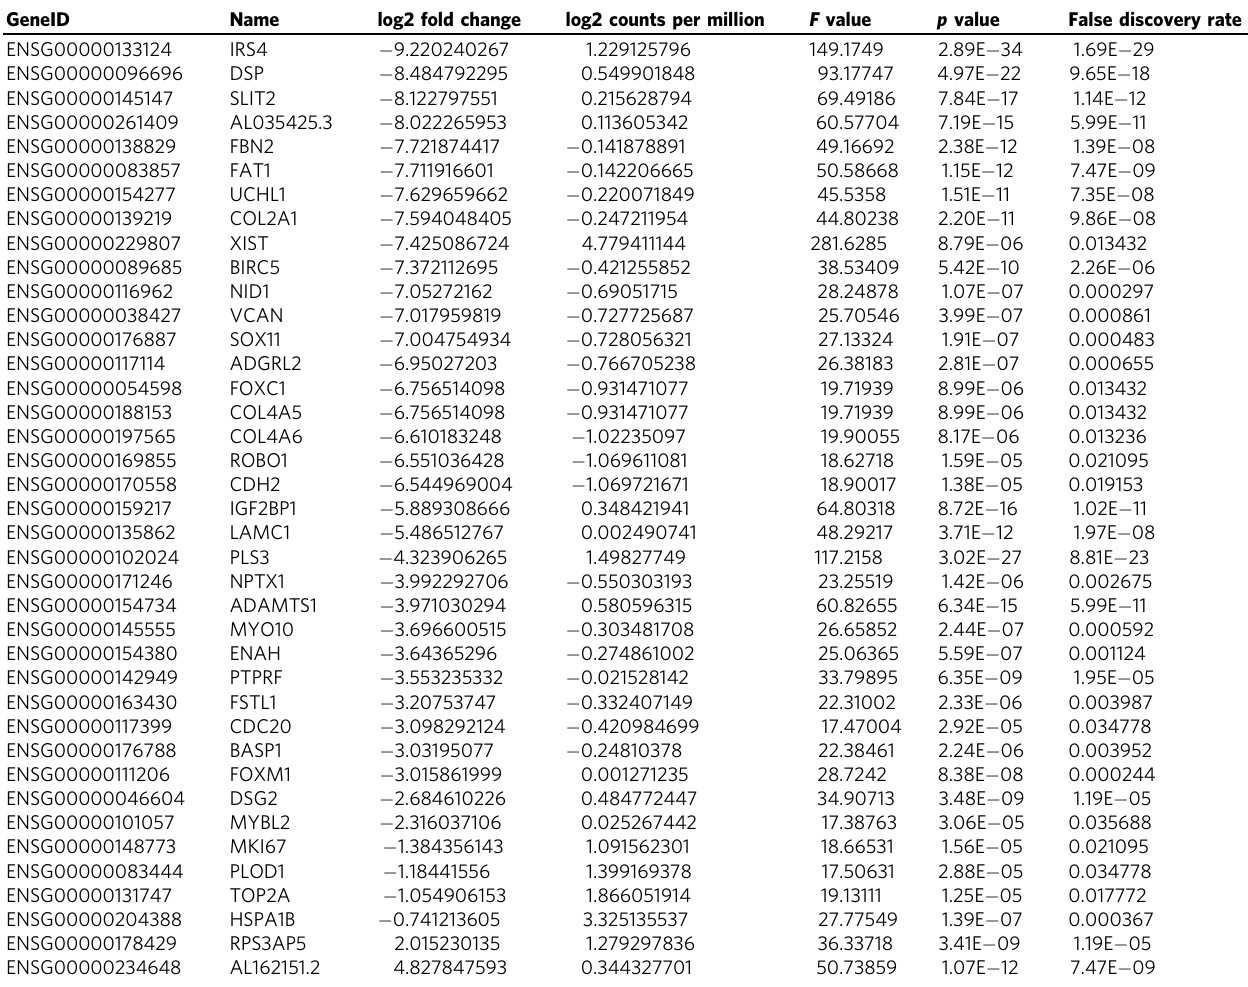
Table 1 EdgeR report of differentially expressed genes 18 h post-treatment with 2 µ M